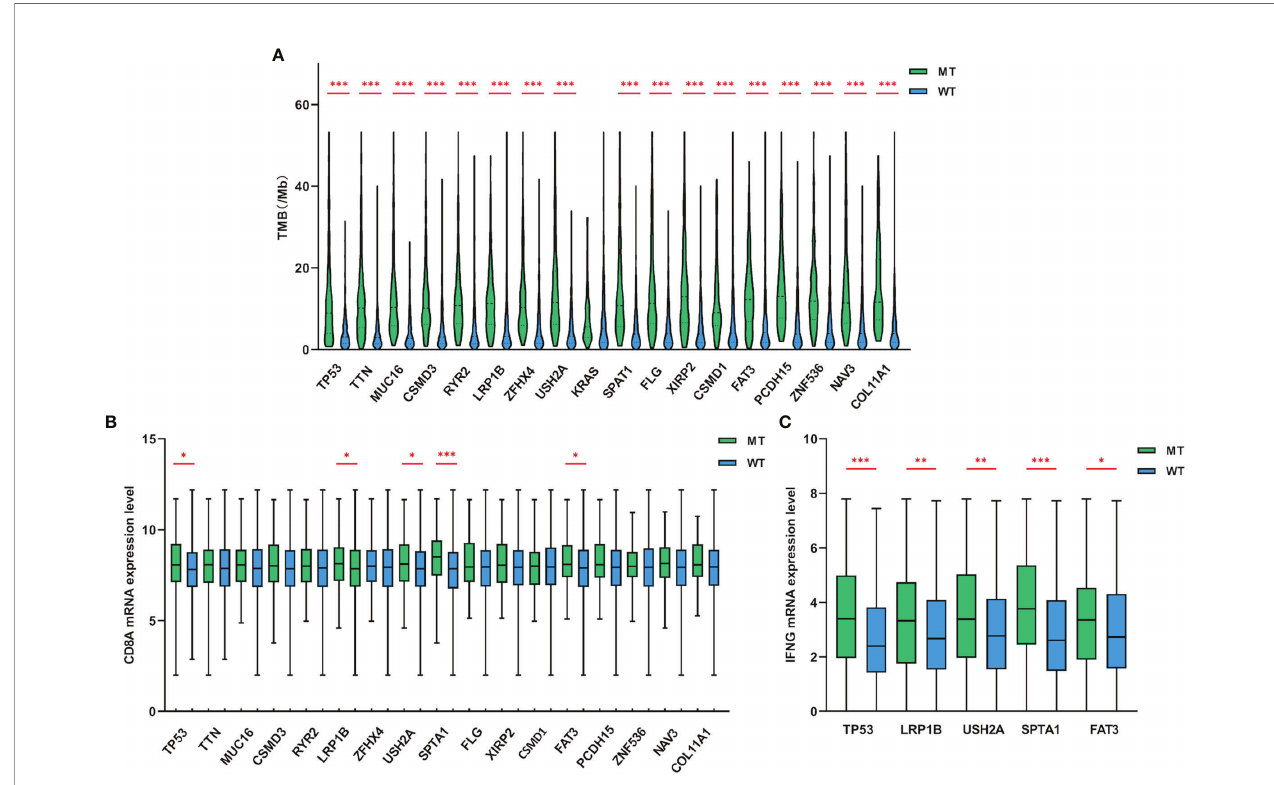
FIGURE 2 | Gene mutations were related to TMB and the expression levels of CD8A and IFNG. (A) Compared with wild-type groups, LUAD samples with TP53, TTN, MUC16, CSMD3, RYR2, LRP1B, ZFHX4, USH2A, SPTA1, FLG, XIRP2, CSMD1, FAT3, PCDH15, ZNF536, NAV3 and COL11A1 mutations had signi fi cantly higher TMB. (B, C) LUAD samples with TP53, LRP1B, USH2A, SPTA1 and FAT3 mutations had higher CD8A and IFNG mRNA expression levels (adding one pseudo-count and log 2 transformation) than wild-type. WT=wild-type. p values indicate comparisons between mutant and wild-type LUADs by Mann-Whitney test. *p < 0.05, **p < 0.01, ***p <